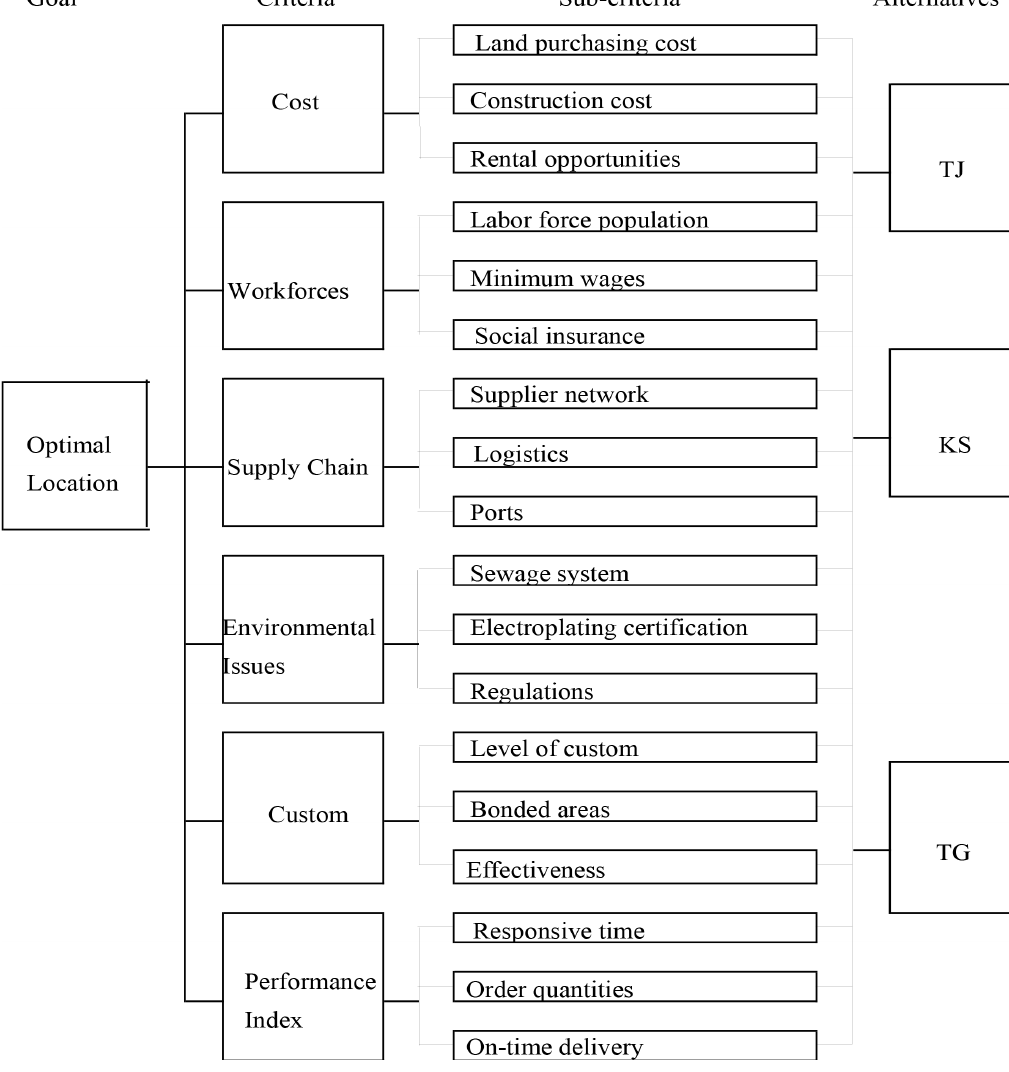
Figure 1. Structure of criteria